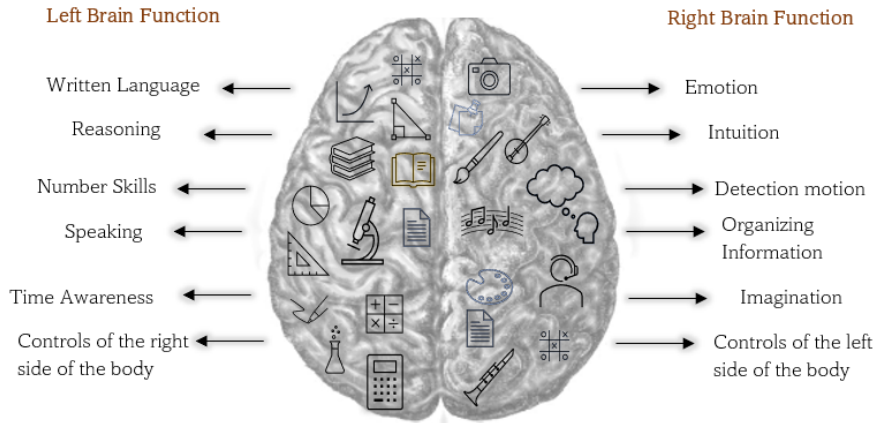
Figure 1. This image shows that any disorder in the brain’s left hemisphere would lead to important difficulties in a person’s ability to read and write and some other